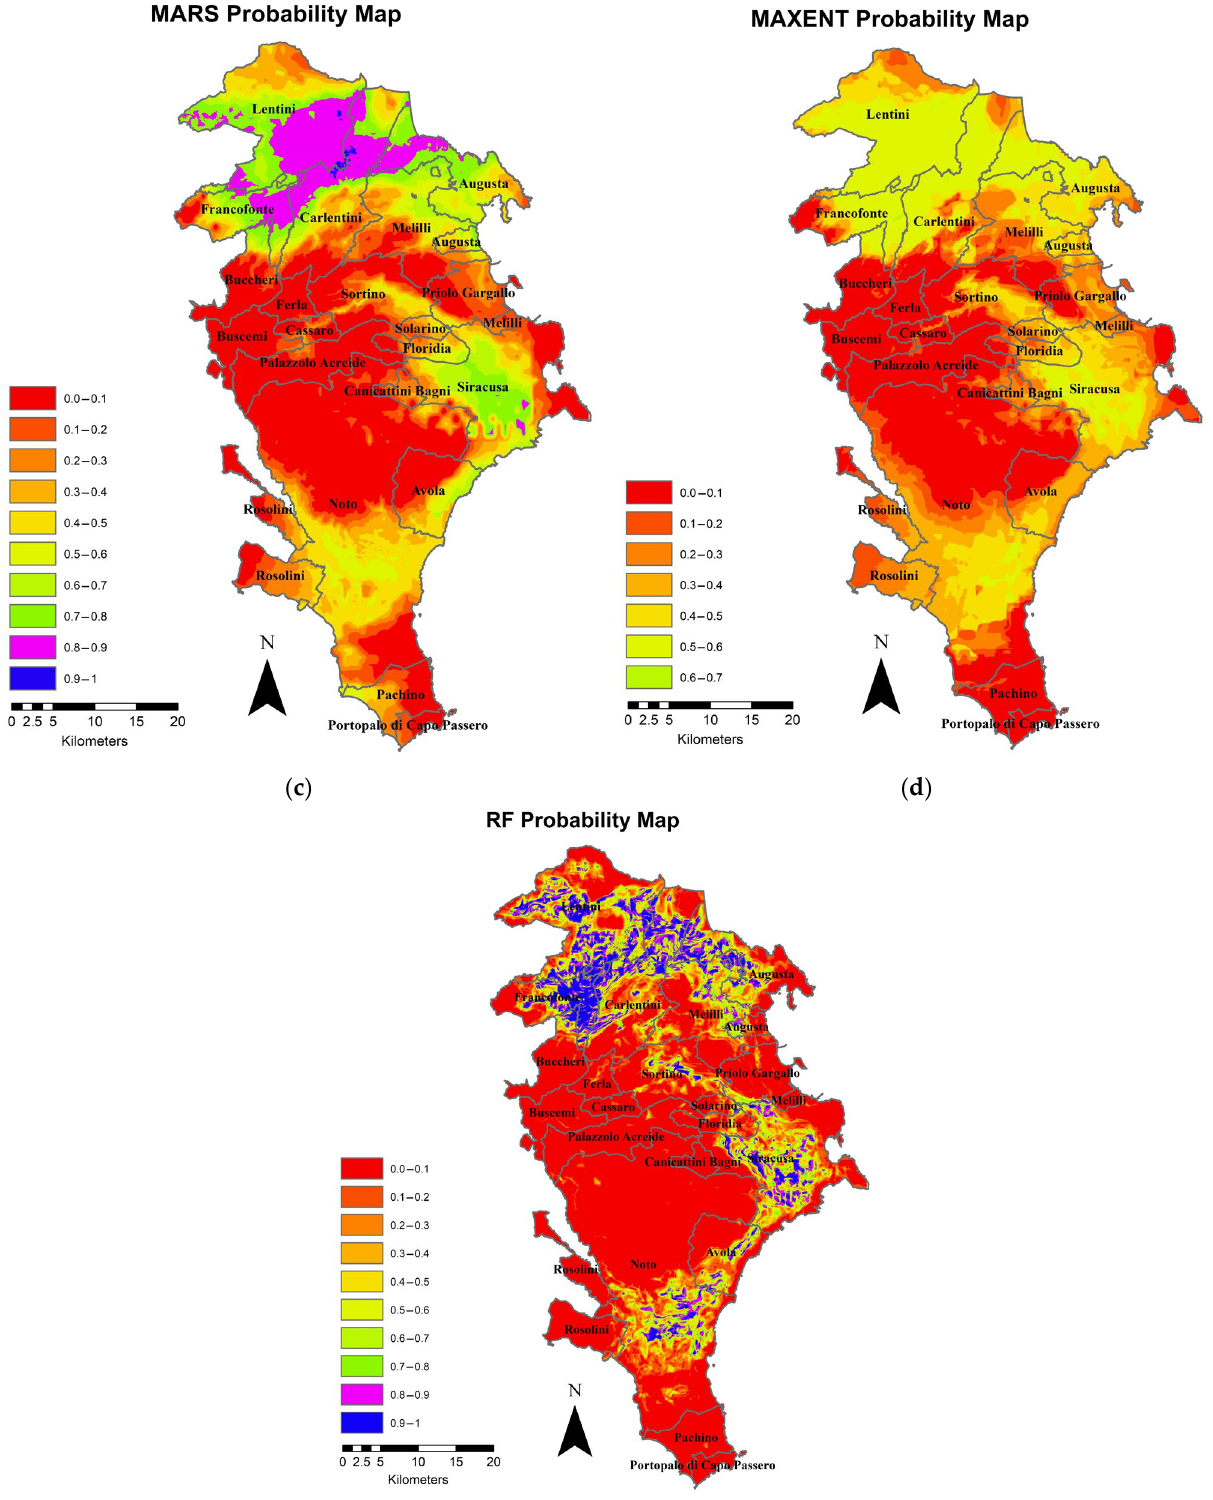
Figure 5. Probability Maps, obtained by applying the 10-classes subdivision for probability, for each model in the province of Syracuse: ( a ) BRT; ( b ) GLM; ( c ) MARS; ( d ) MaxEnt; and ( e ) RF. Moreover, the sum of the surfaces from Class 7 to Class 10 for each model that re- quired summing the values from Class 5 to 10, except for the MaxEnt model, confirmed